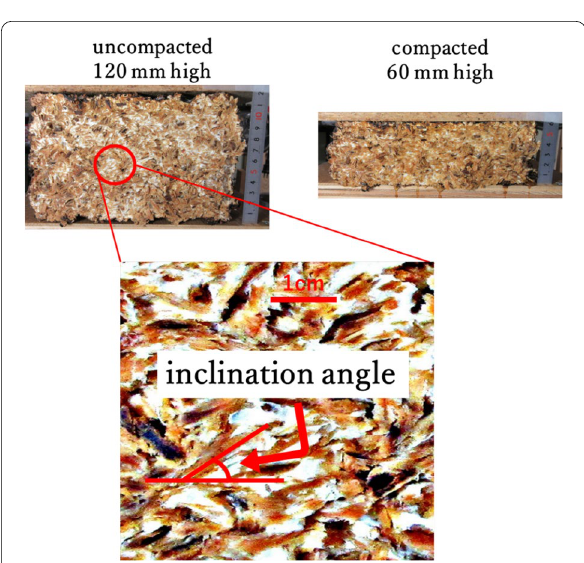
Table 1 Wood and wood-based panels for thermal